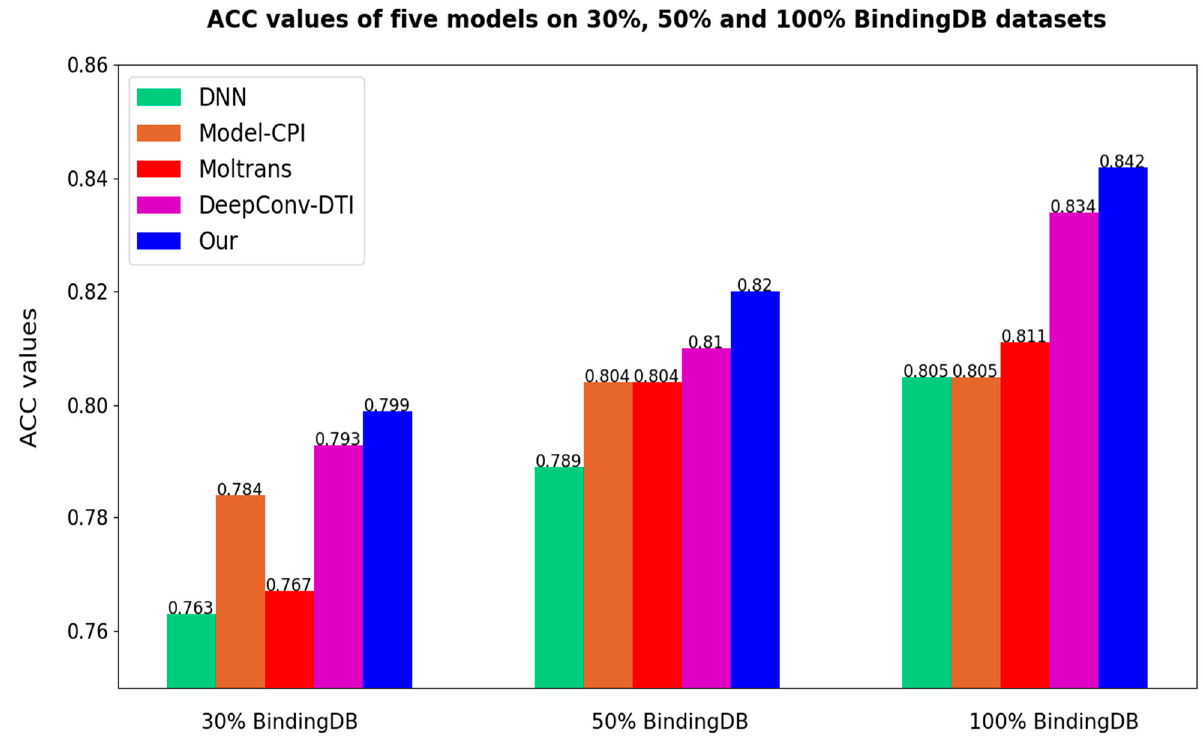
Figure 7. Comparisons of different models on ACC (Our = Multi-TransDTI).